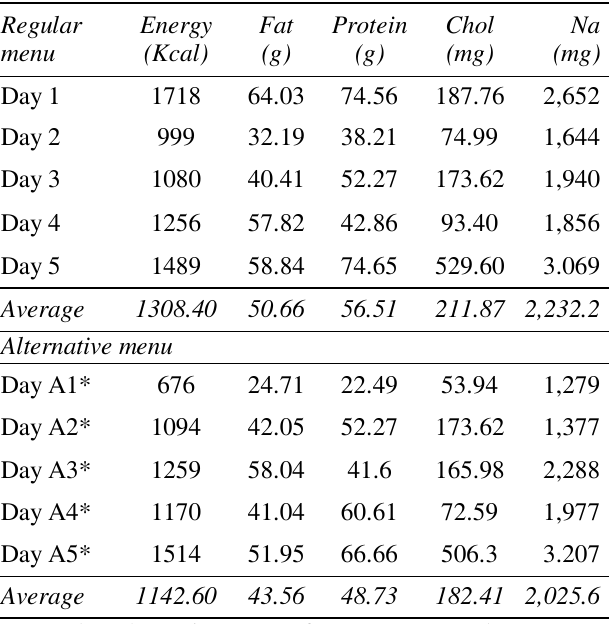
Table 4: Jackson Public Schools’ menu analysis for